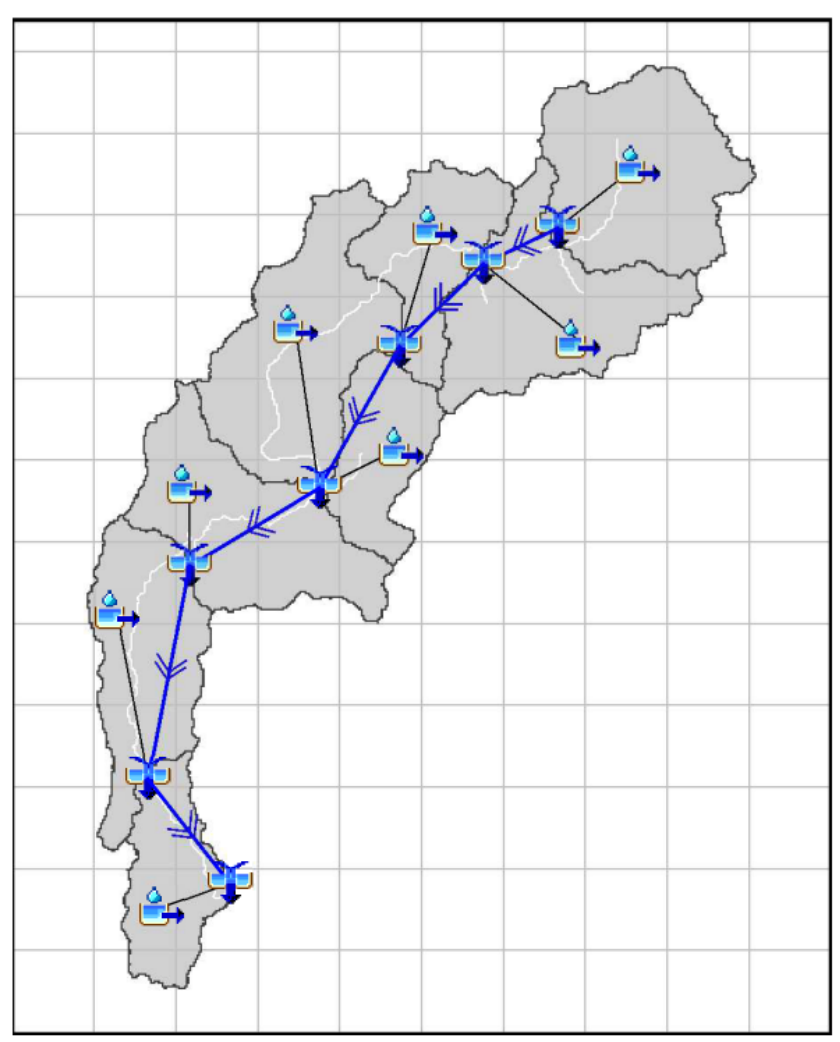
Figure 5. Schemetic diagram for the setup of HEC-HMS hydrological modeling system.